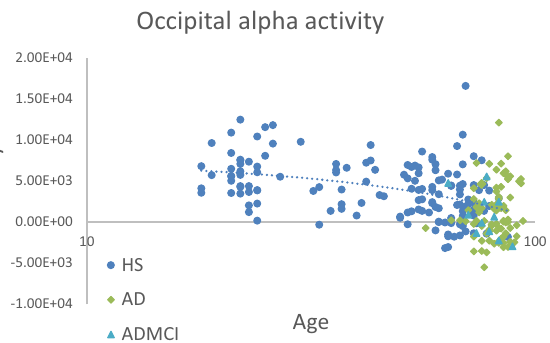
Figure 4. Occipital alpha activities of AD patients, ADMCI patients, and healthy subjects. Compared to 147 healthy subjects (blue circles), 90 AD (green squares) and 11 ADMCI (bright blue triangles) patients showed significantly decreased activities in the occipital alpha activity, where the age difference between the AD/ ADMCI and healthy groups was corrected by linear regression